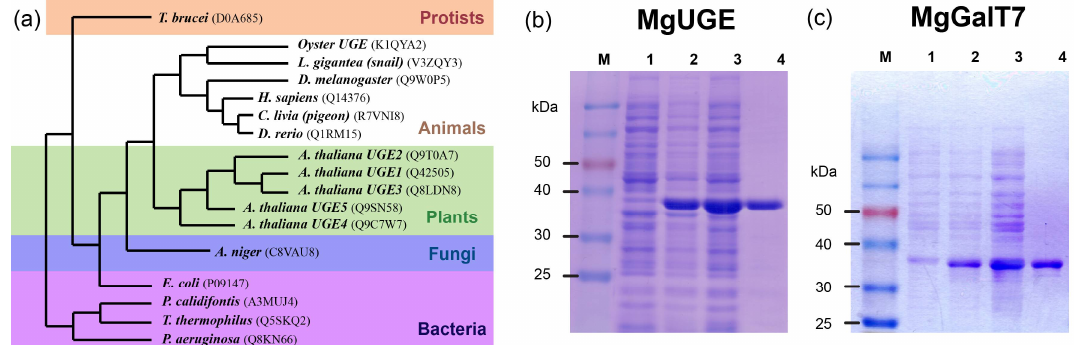
Figure 1. ( a ) Phylogenetic relationship of functionally characterized UGEs, with UniProt identifiers shown in parentheses. SDS-PAGE analyses of recombinant ( b ) UGE from Magallana gigas (MgUGE), and ( c ) β-1,4-galactosyltransferase from Magallana gigas (MgGalT7), at various stages of expression and purification. M —protein marker; 1 —cell pellet before induction, 2 —cell pellet after induction with isopropyl-β- D -thiogalactopyranoside (IPTG), 3 —supernatant after cell lysis, and 4 —purified protein.